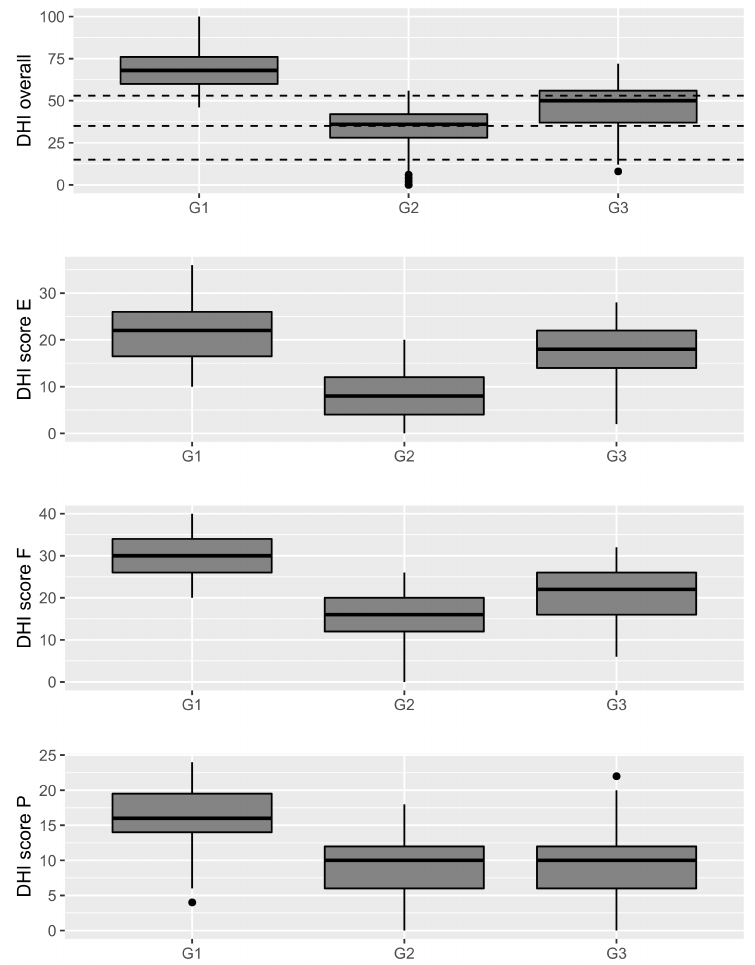
Figure 5. Boxplot charts of Dizziness Handicap Inventory (DHI) overall scores and DHI component scores (E = Emotional, F = Functional, P = Physical), classified by the three groups (Group 1 (G1), Group 2 (G2) and Group 3 (G3)) obtained from the Cluster Analysis (see Figure 4). In the top boxplot, horizontal lines indicate the DHI cutoffs for the four handicap